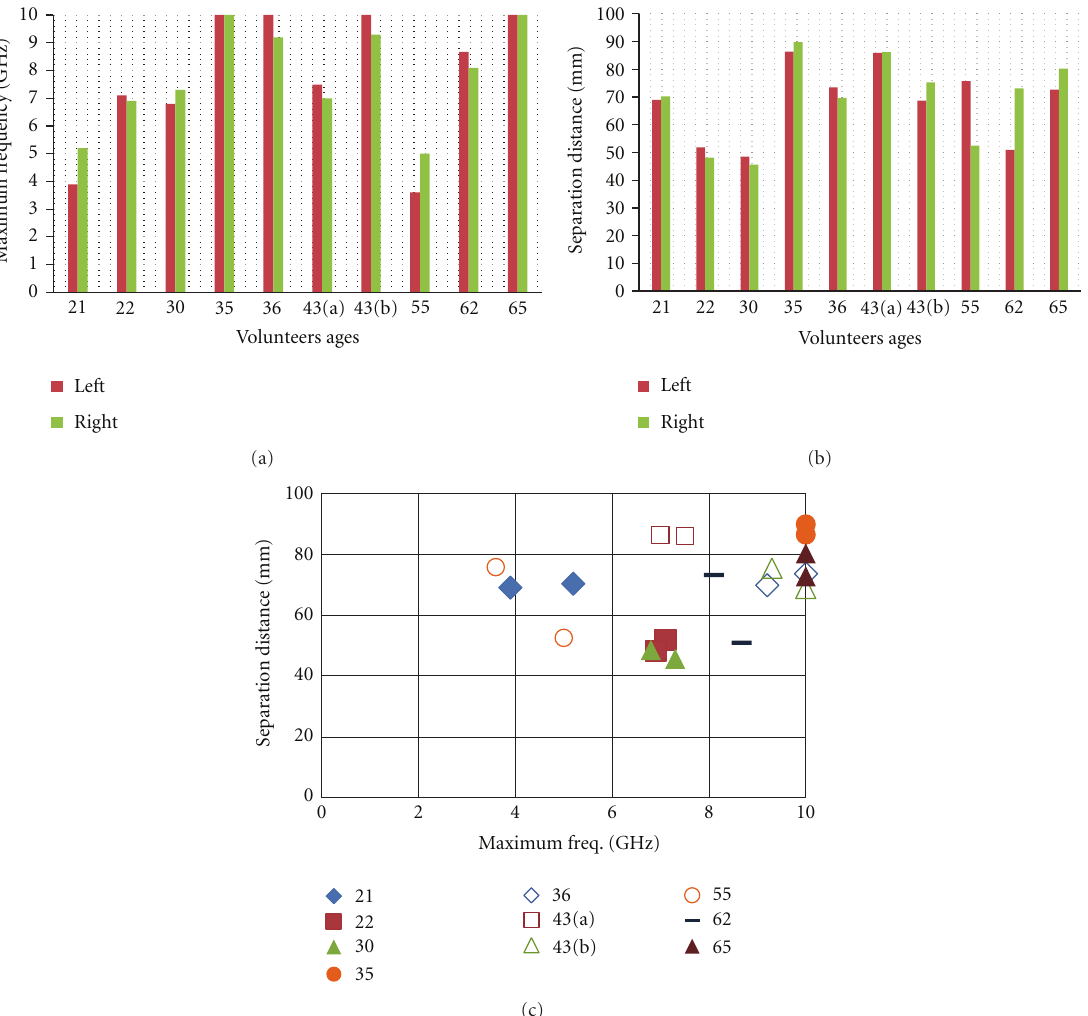
Figure 14: Measurement results: (a) maximum frequency and (b) separation distances in function of volunteer ages. (c) separation distance as a function of maximum frequency for each volunteer breast.